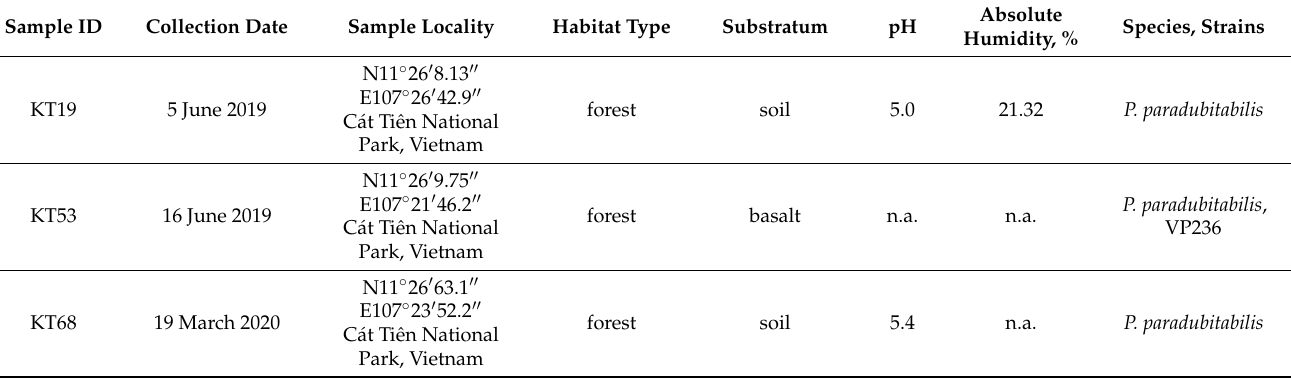
Figure 1. Sampling sites landscape in Cát Tiên National Park, Đồ ng Nai Province, Vietnam. ( A ) Forest (KT55). ( B ) The bottom of a dry reservoir (KT39). ( C ) Dry swamp (KT61). ( D ) Agricultural field (KT54). Table 1. The geographic position of samples and measured ecological parameters.